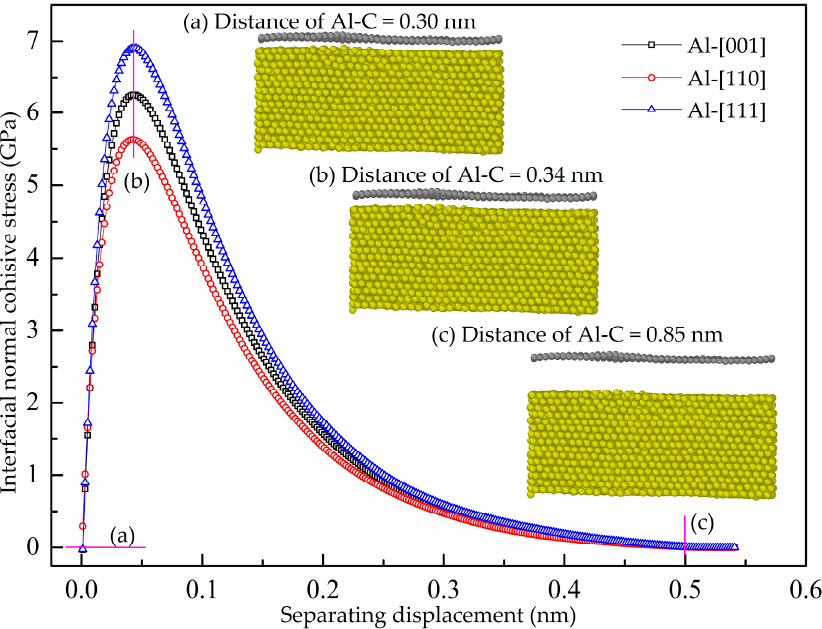
Figure 16. Interfacial normal cohesive stress—separating displacement curves.